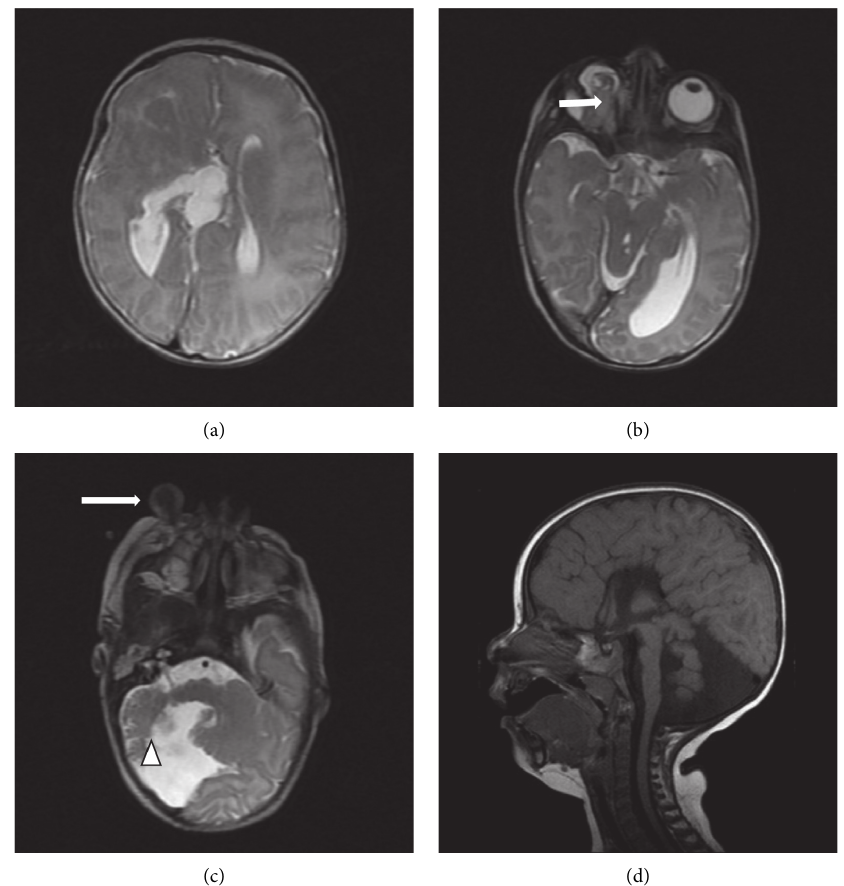
Figure 2: Axial images of T2W MRI demonstrated (a) colpocephaly and agenesis of the corpus callosum, (b) a mixed cystic solid structure in the right orbital cavity (black arrow), and (c) a cutaneous appendage in the right infraorbital area (white arrow), aplasia of the vermis, hypoplasia of the right cerebellar hemisphere (head arrow), and widening of the CSF space in the posterior fossa. Sagittal image of T1W MRI in midline showed (d) agenesis of the corpus callosum and cerebellar hypoplasia.